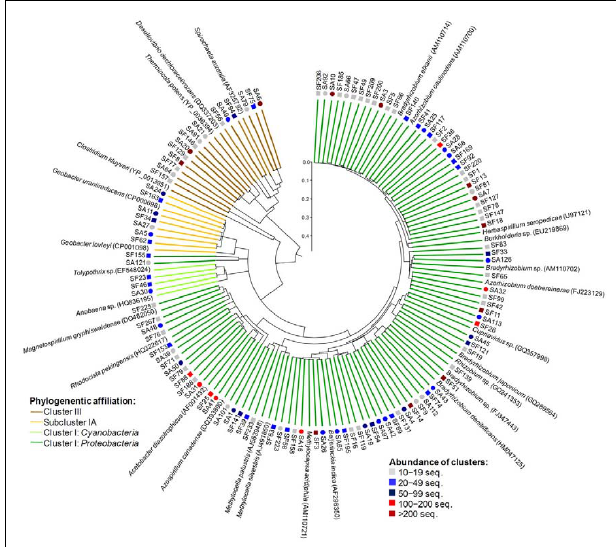
FIGURE 7 | Phylogenetic composition of the nitrogenase gene ( nifH ) amplicon libraries of S. angustifolium (SA, circles) and S. fallax (SF, squares) . Neighbor-joining phylogenetic tree was constructed with both one representative sequence per NifH cluster (92% similarity) and the nearest reference sequences (accession numbers in brackets). A partial sequence of the light-independent photochlorophyllide reductase subunit L (BchL) from Chlorobaculum tepidum (Acc. Nr. AAG12203) was used as out-group. Reliability of the tree topology was evaluated by 100 bootstrap resamplings (bootstrap values not shown). Abundance and phylogenetic affiliation of the clusters are indicated at the legend. Scale bar = 0.1 substitutions per